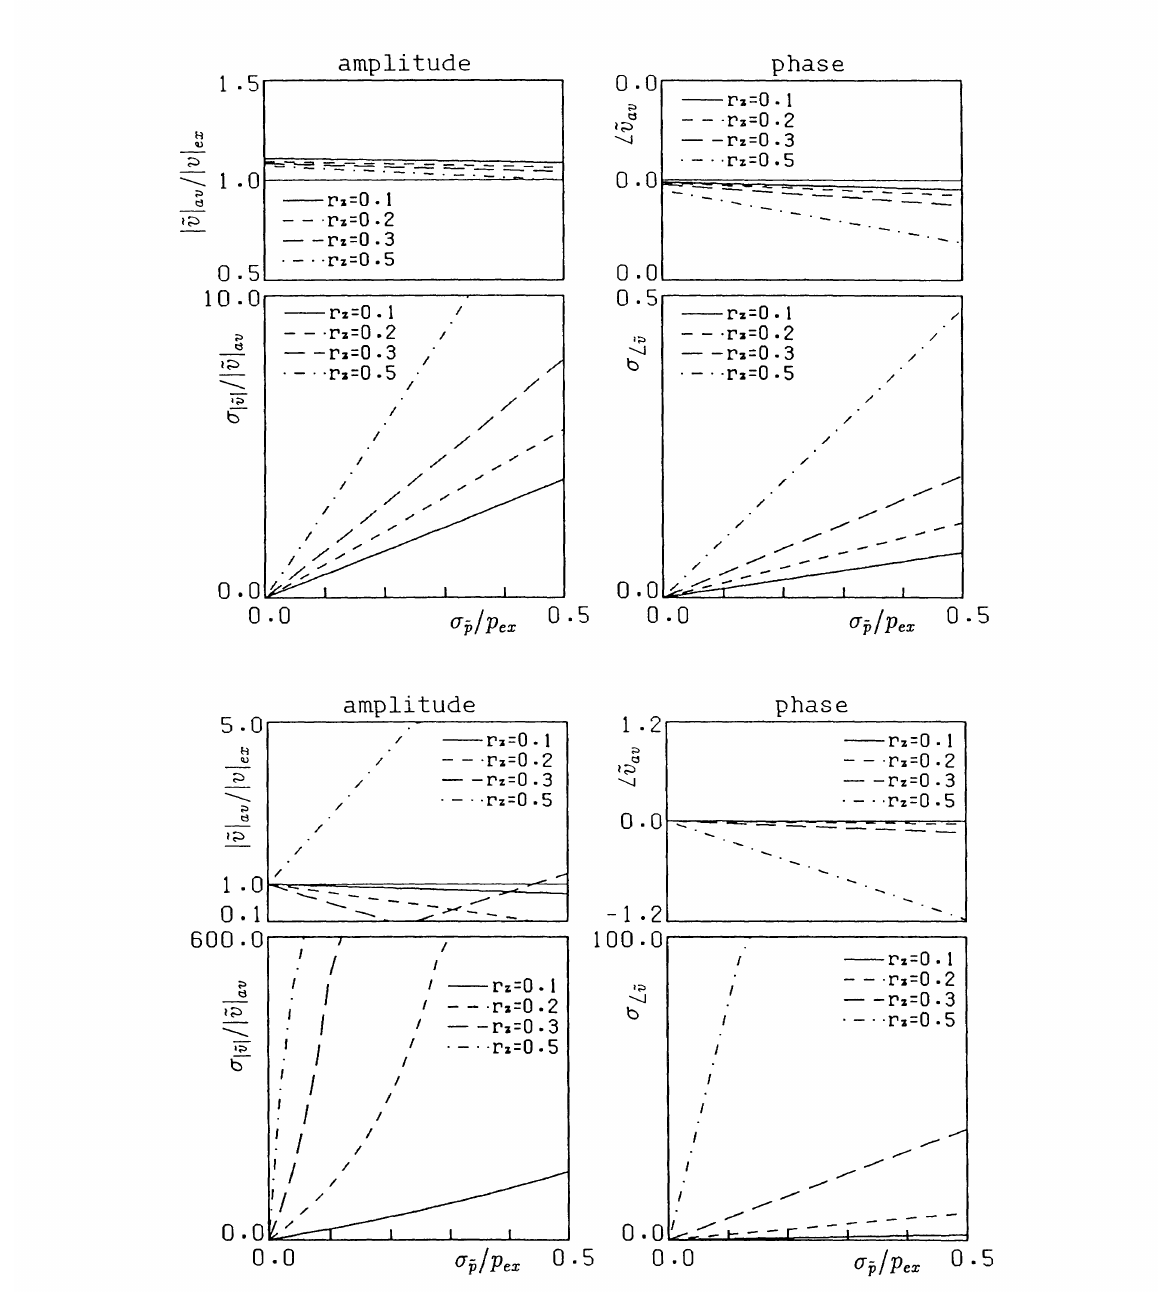
FIGURE 6 Error expanding ratio by Monte Carlo simulation: (a) mode-superposition method and (b) BEM direct